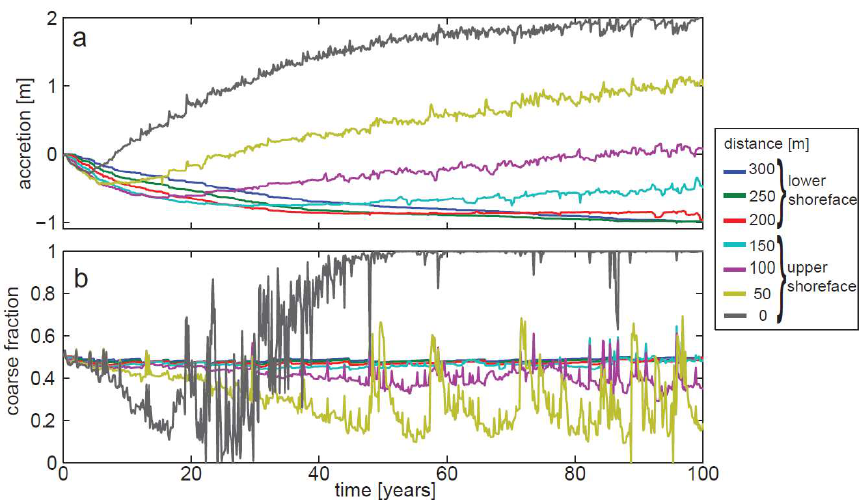
Figure 8. Results of the hydro-sedimentary model. Starting from the initial profile, changes in bed elevation ( a ) and grain size ( b ) are plotted over time at different locations along the modeled shore profile (see Figure 7). The bed elevation and size distribution reach a statistically steady state after about 100 years of morphological evolution. Fluctuations caused by variable wave conditions are present throughout.